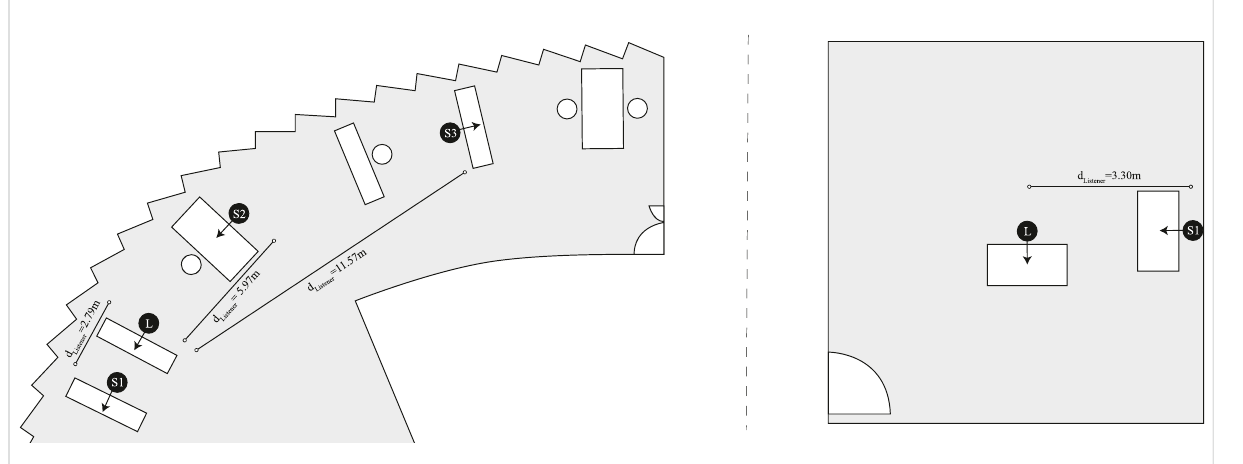
FIGURE 2 Floorplansoftherooms(grayarea)usedin Experiment1 (left)and Experiment2 (right)withlistener(L)andspeaker(S1,S2,S3)positionsinblack, of fi ce desks and head orientation. Ear height of both the speaker and listener positions: 1.20 m.